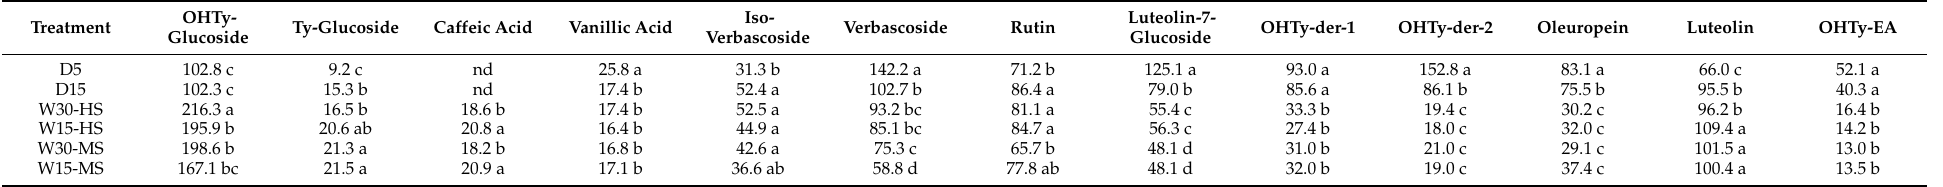
Table 1. Phenolic compounds analyzed by HPLC-DAD in ‘Itrana’ table olives after 5 and 15 days of fermentation in water (D5 and D15, respectively) and at the end of four 165-day-long processing methods: 30 days in water and then salting with 8% NaCl brine (W30-HS); 15 days in water and then salting with 8% NaCl brine (W15-HS); 30 days in water and then salting with 6% NaCl brine (W30-MS); 15 days in water and then salting with 6% NaCl brine (W15-MS). Within each column, different letters indicate significant differences between treatments according to Tukey’s test ( p ≤ 0.05). Values are expressed as mg internal standard per kg of olive pulp ( n =